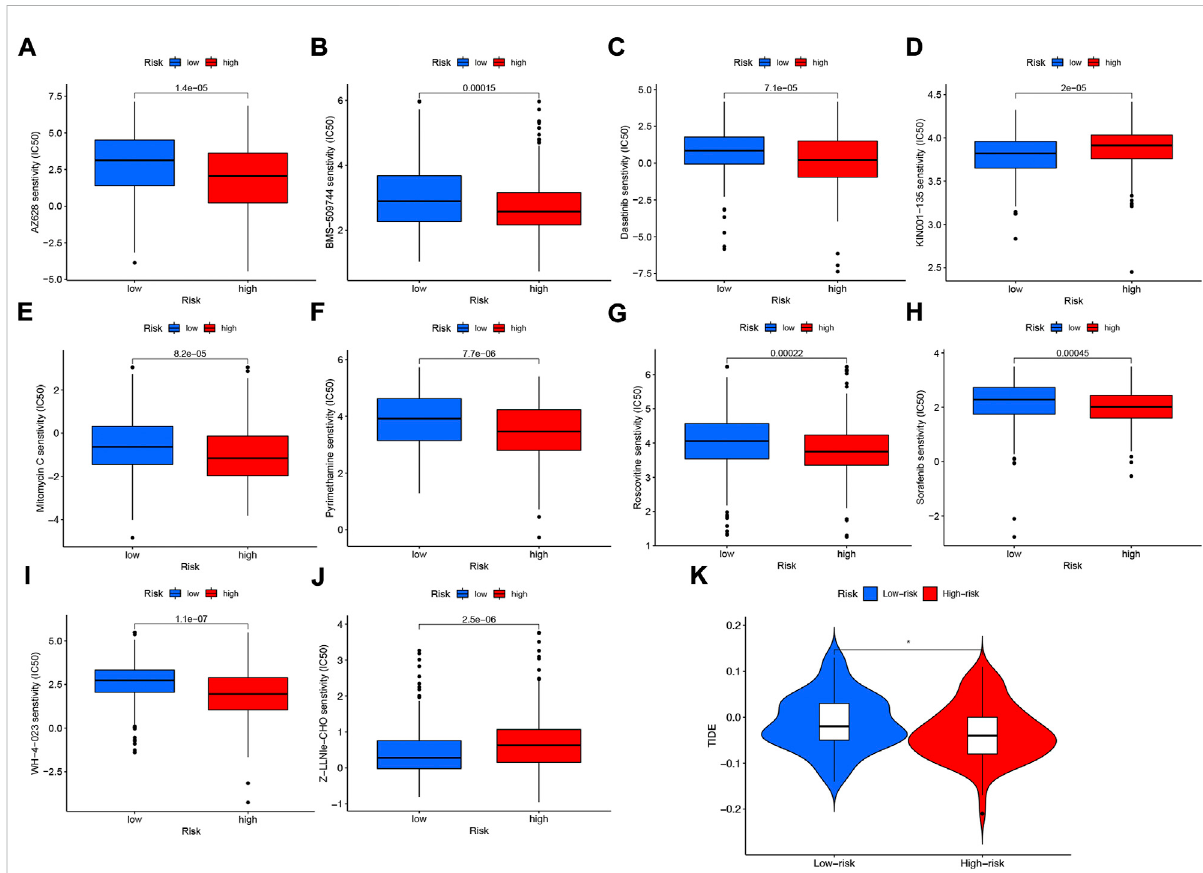
FIGURE 12 Differences in IC50 of immunotherapy drugs by risk score (A) AZ628, (B) BMS-509744, (C) Dasatinib, (D) KIN001-135, (E) Mitomycin C, (F) Pyrimethamine, (G) Roscovitine, (H) Sorafenib (I) WH-4-023 (J) Z-LLNle-CHO . (K) TIDE score differences between high- and low-risk groups. * p < 0.05; ** p < 0.01; *** p <